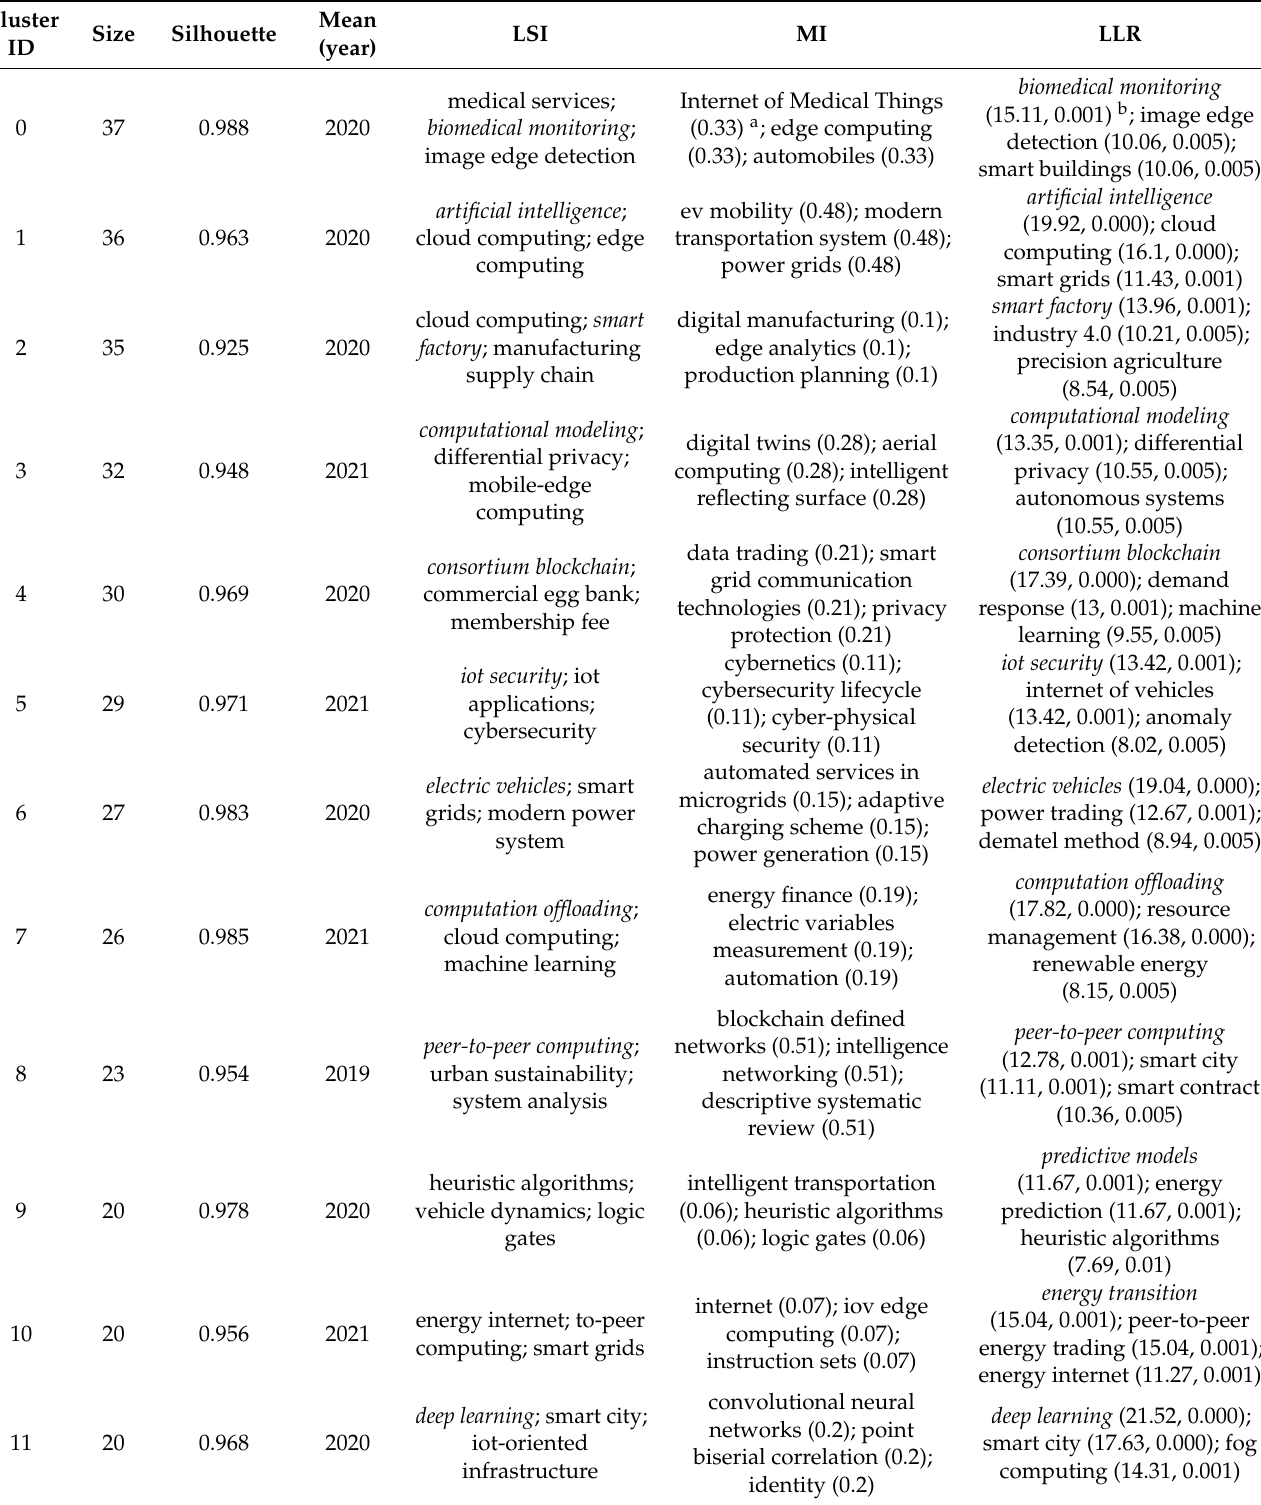
Table A2. Summary of the largest keywords’ co-occurrence clusters in the subject